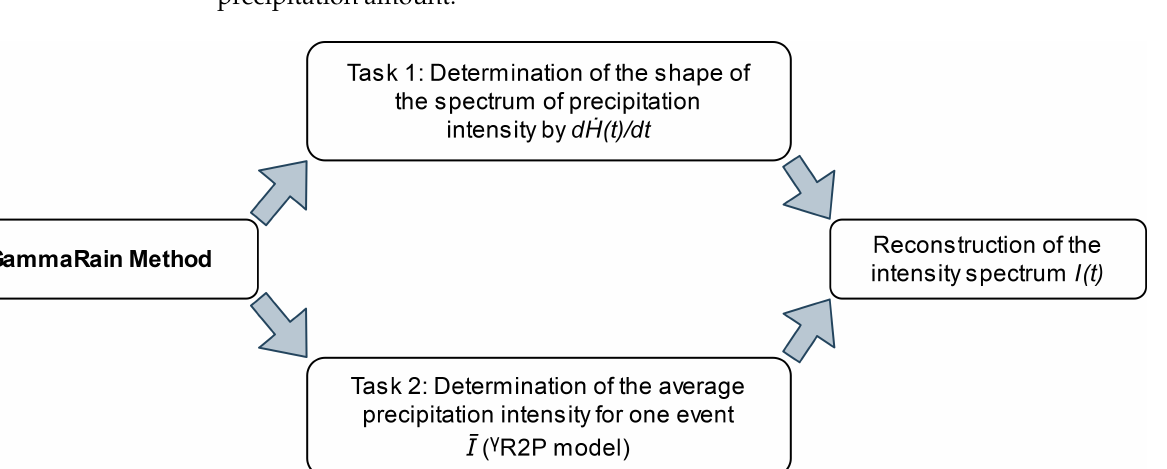
Figure 3. Algorithm (scheme) of GammaRain method